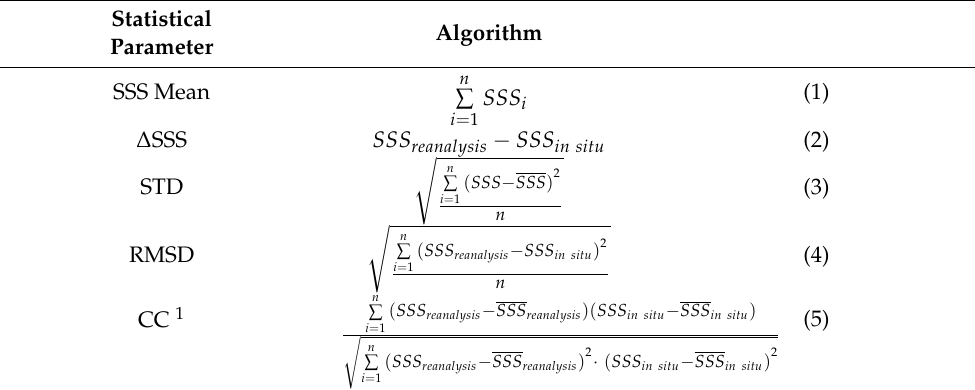
Table 2. Algorithm for calculating fundamental statistic parameters for assessment in this study. Statistical